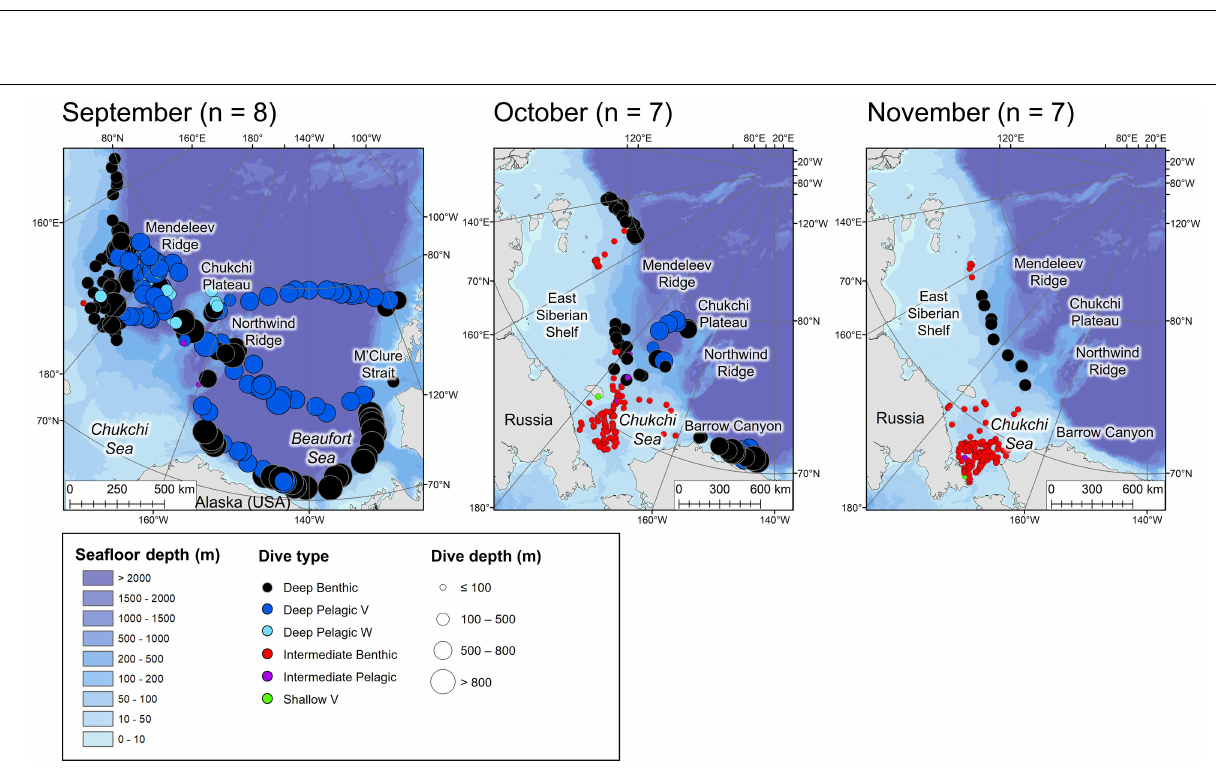
Frontiers in Marine Science |